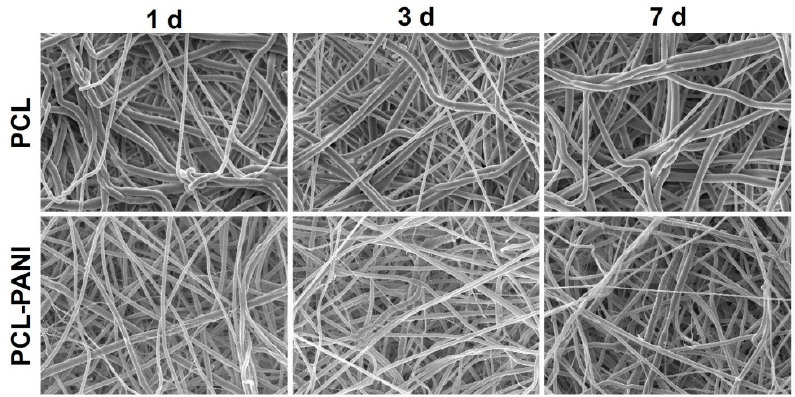
Figure 4. FESEM images of PCL and PCL-PANI mats after 1, 3 and 7 days of hydrolytic degradation (scale bar = 10 µm, magnification = 5 K×).